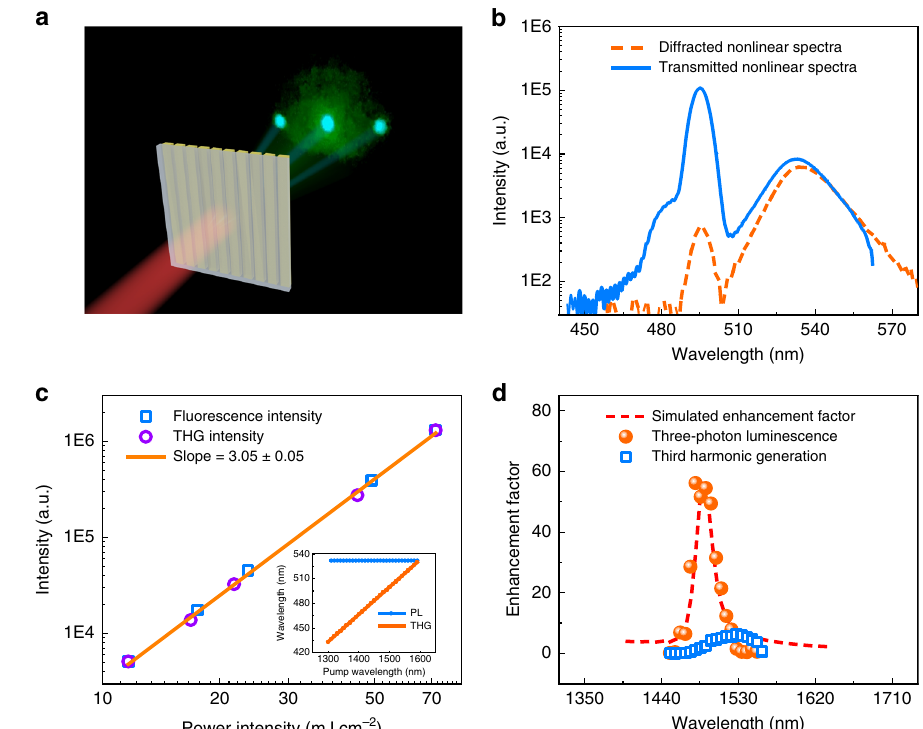
Fig. 4 The nonlinear characterization of MAPbBr 3 perovskite metasurfaces. a The schematic picture of the nonlinear characterization. The insets are the experimentally recorded images of perovskite metasurfaces. b The transmitted (solid line) and diffracted (dashed line) nonlinear spectra. c The integrated intensity of photoluminescence as a function of incident power. Here the wavelength is fi xed at 1500 nm. d The enhancement factor of three-photon luminescence and THG as a function of incident wavelength. Here the pumping density is kept at 30 mJ cm − 2 . The dashed line is the corresponding numerically simulated resonant enhancement of incident laser by taking into account the actual size and morphology of the fabricated